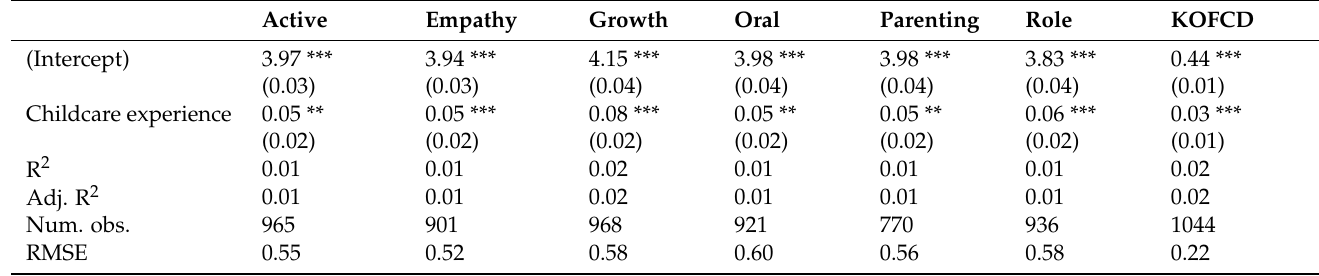
Table 8. Associations between prior childcare experience and APKAS responses by category.